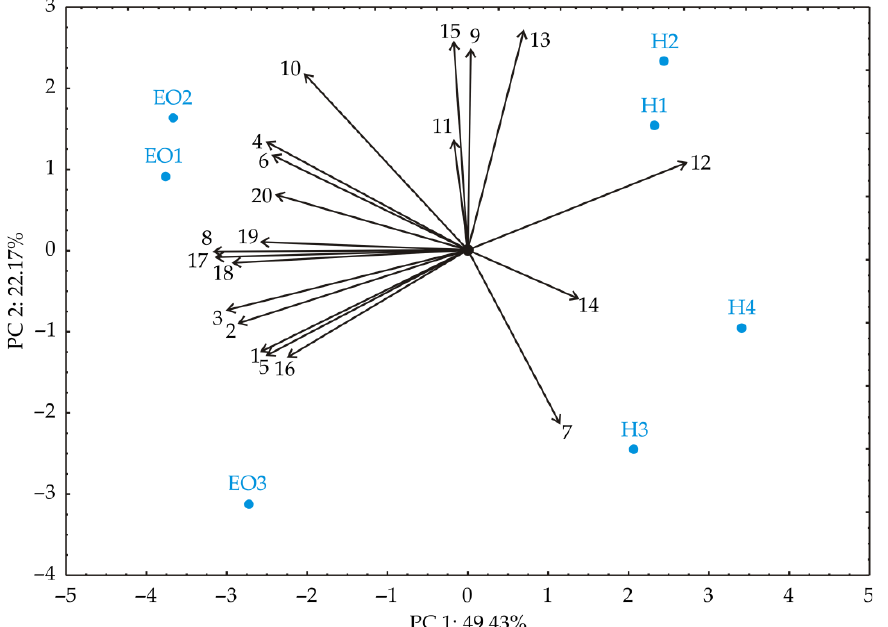
Figure 6. The PCA biplot diagram describing the relations between volatile compounds of essential oil and hydrolate composition according to this study and the literature .